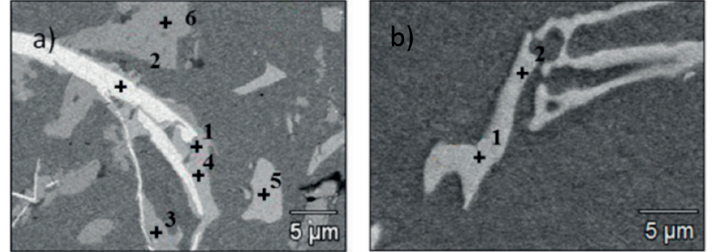
Figure 2. SEM micrographs and EDS analysis performed in ( a ) AlSi 7 Mg and ( b ) AlSi 10 Mg, respectively. Reprinted with permission of [4].